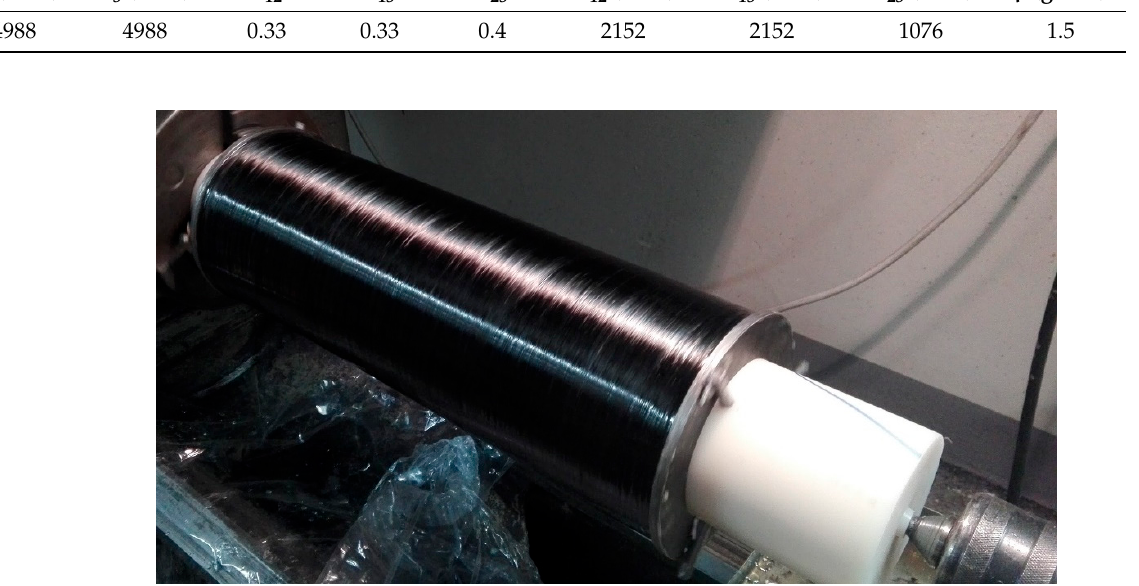
Figure 1. Diagram of the arrangement of temperature sensors (all dimensions in mm). Table 2. Material data used for FEM analysis.